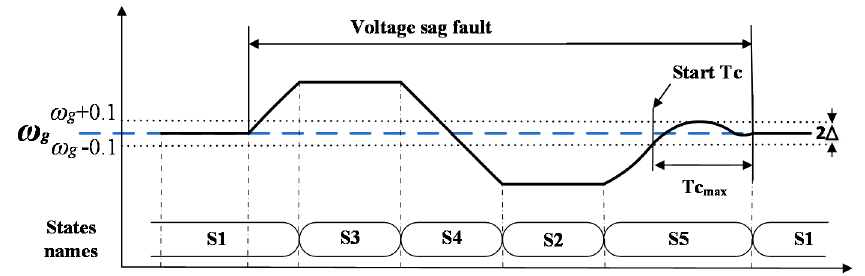
Figure 6. Proposed finite state machine (FSM) for the SOGI-FLL.